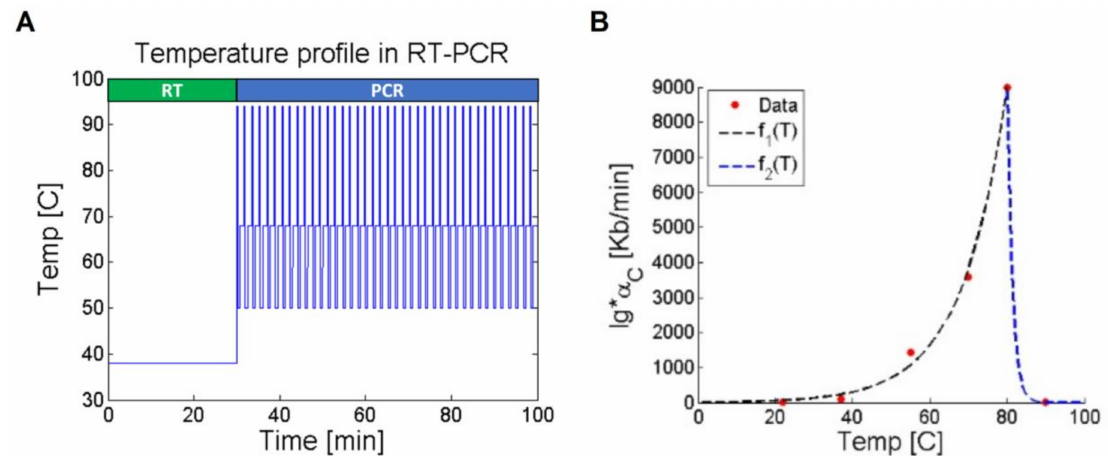
Figure 2. Temperature dynamic. ( A ) Temperature profile for the RT and PCR phases. In the PCR, the temperature changes according to three cyclic values (93, 50, and 68 ◦ C). ( B ) Fitted data to model the DNA polymerase activation speed ( α c ) in function of the temperature (R 2 = 0.99 using the nonlinear least squares method). The polymerase speed units are kilobases per minute (Kb/min), and lg is the transcript longitude in number of bases. For each segment, we used a one term exponential model ( Ae T / B ). Dots represent experimental values [17], and the discontinued lines are the fitted piecewise function comprising two segments (Equation